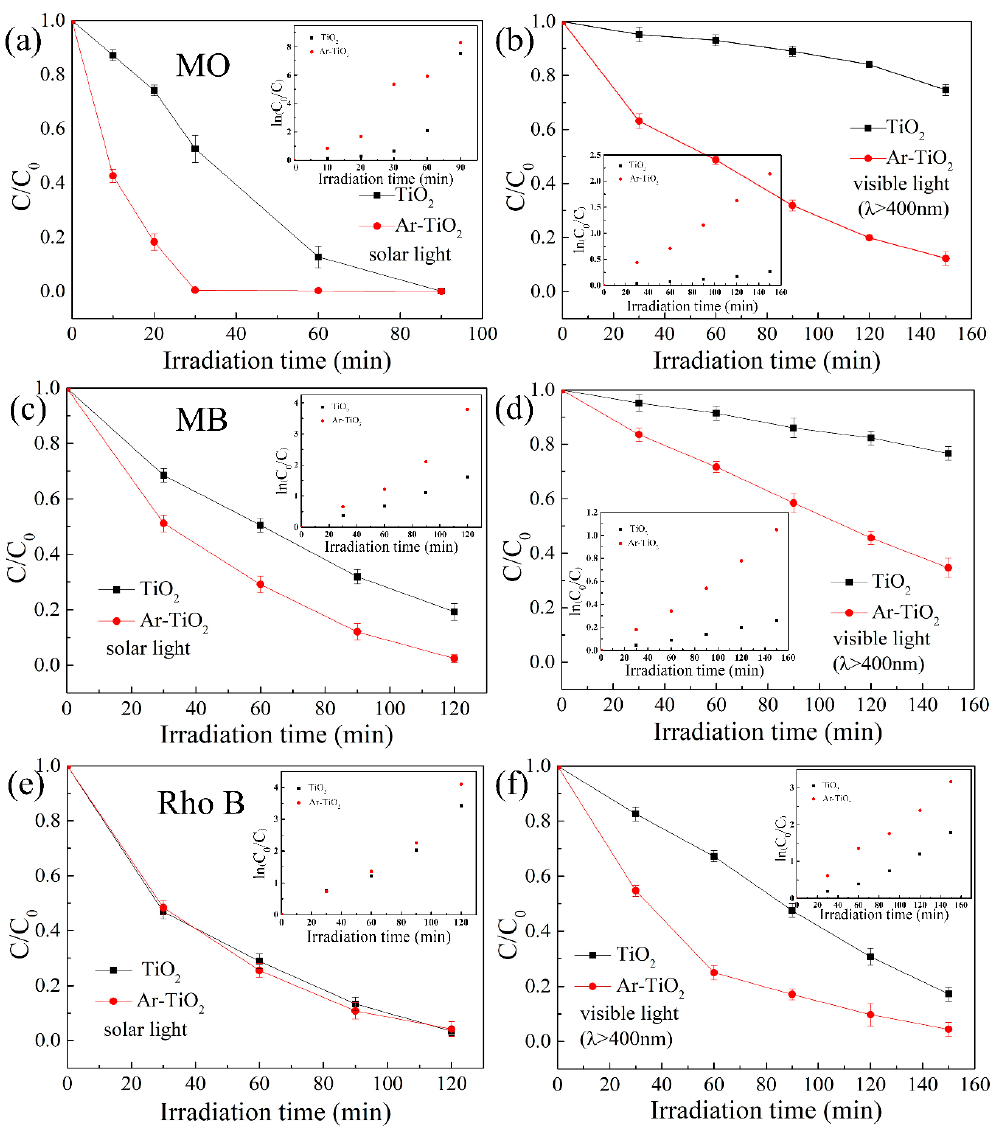
Figure 6. Removal of ( a , b ) methyl orange (MO), ( c , d ) methylene blue (MB) and ( e , f ) rhodamine B (Rho B) by TiO 2 and Ar-TiO 2 (inset: corresponding degradation rate images) under solar light and / or visible light ( λ ≥ 400nm) irradiation. Solution concentration: 10 mg/L; organic solution: 100 mL; catalyst: 50 mg. Table 3. Degradation rates, k (h − 1 ), of TiO 2 and Ar-TiO 2 after photocatalytic degradation of MO, MB and Rho B dyes.